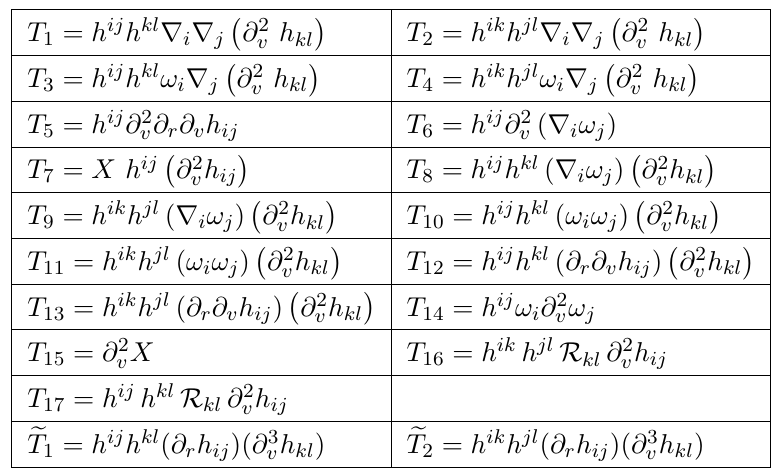
Table 7 . Listing the seventeen T i ’s and two e T i ’s, the possible 4-derivative scalar data with boost weight = 2. They are candidate terms that appear in E HD for 4-derivative theories of gravity. The vv seventeen T i terms will contribute to k = 0 sector, and the two e T i terms will contribute to k = 1 sector of E HD vv